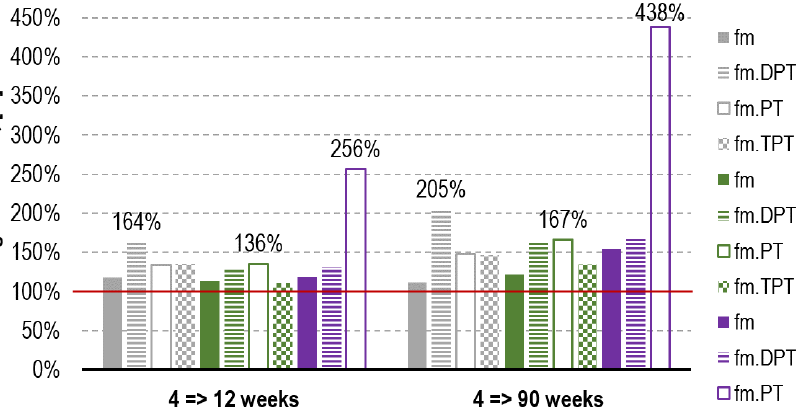
Figure 17. Mortar strength increase in time period between 4th and 12th week (e.g., f m (12) / f m (4) ) and between 4th and 90th week (e.g., f m.DPT (90) / f m.DPT (4) ). The red line represents the compressive strength established after 4 weeks of curing. The respective test types are marked with a given filling style, and the respective mortar types are marked with a given color.